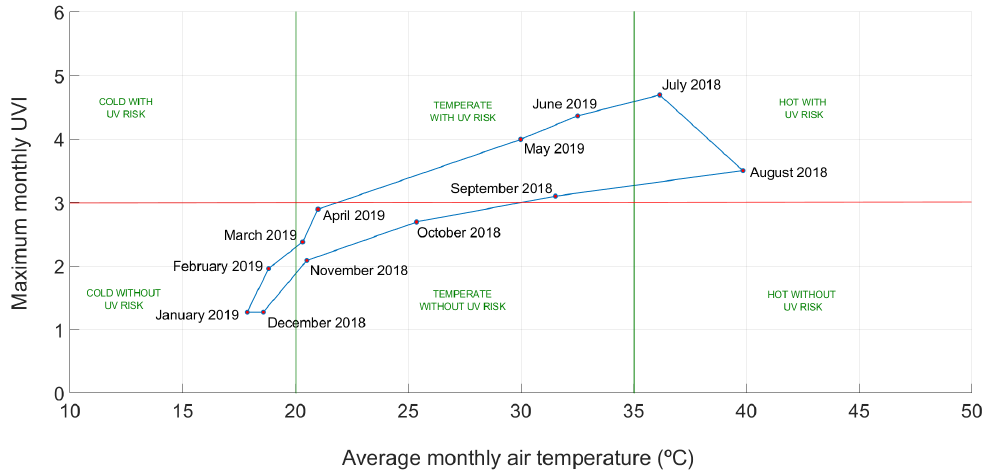
Figure 12. UVIgram that relates the average monthly temperature and the maximum monthly UVI inside the greenhouse; the maximum monthly UVI were measured on 5 July 2018 at 12:44 a.m. by MS (Measure Station) 5, 2 August 2018 at 12:27 a.m. by MS 4, 14 September 2018 at 12:21 a.m. by MS 12, 13 October 2018 at 11:59 a.m. by MS 12, 4 November 2018 at 11:59 a.m. by MS 12, 4 December 2018 at 11:58 a.m. by MS 12, 31 January 2019 at 12:40 a.m. by MS 10, 25 February 2019 at 12:14 a.m. by MS 11, 5 March 2019 at 12:42 a.m. by MS 11, 30 April 2019 at 12:47 a.m. by MS 11, 31 May 2019 at 12:16 a.m. by MS 12 and 26 June 2019 at 12:12 a.m. by MS